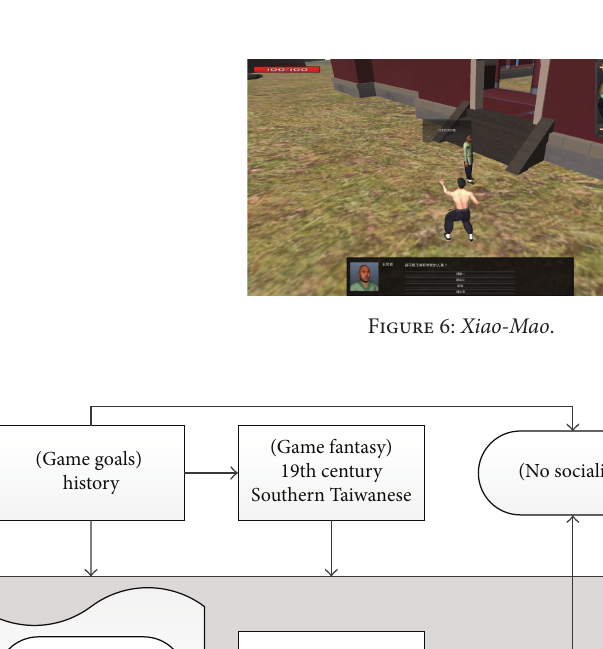
Figure 5: GBL design model for Slice it!